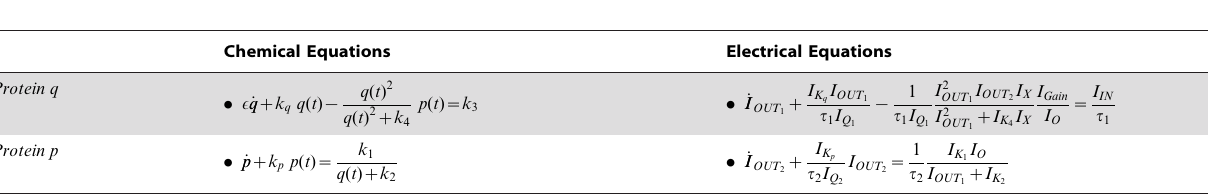
Chemical Equations Electrical